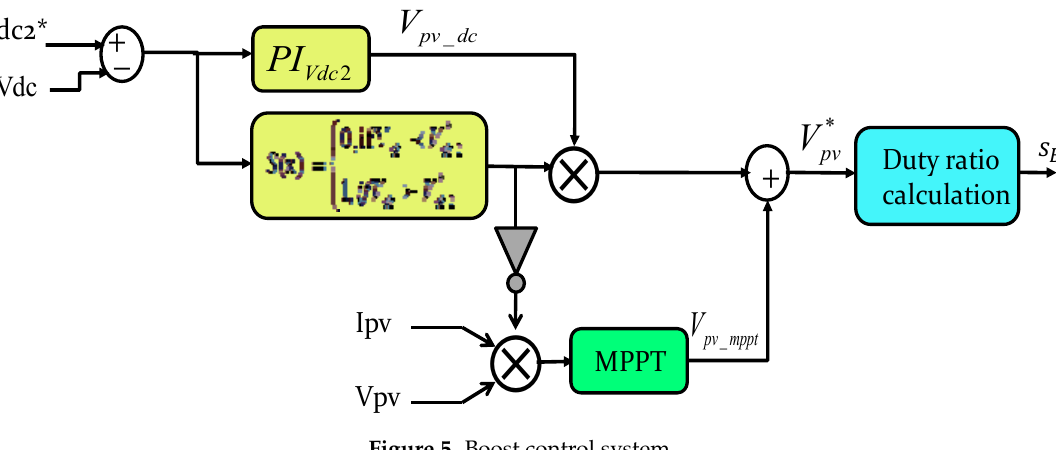
Figure 5. Boost control system.